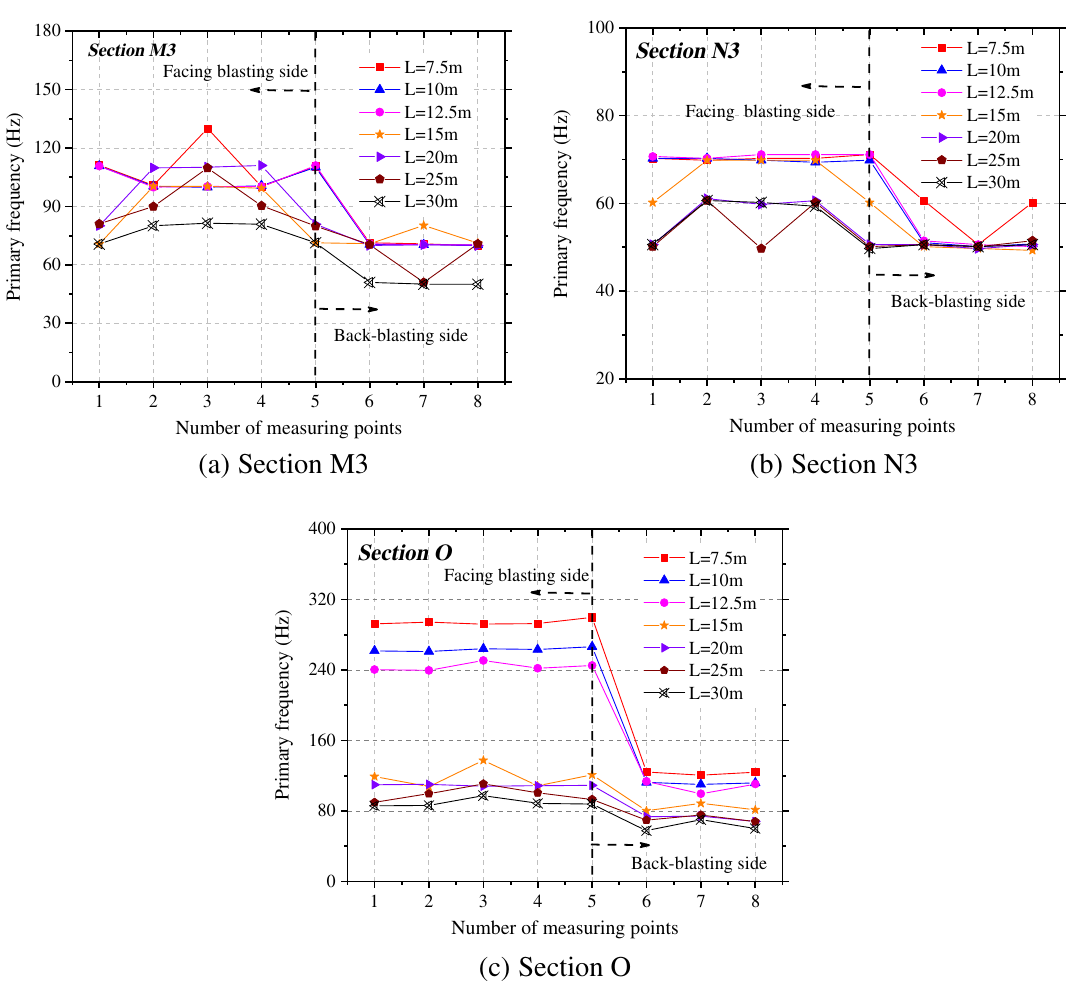
Figure 10. Primary frequency of the adjacent tunnel under different spacings between